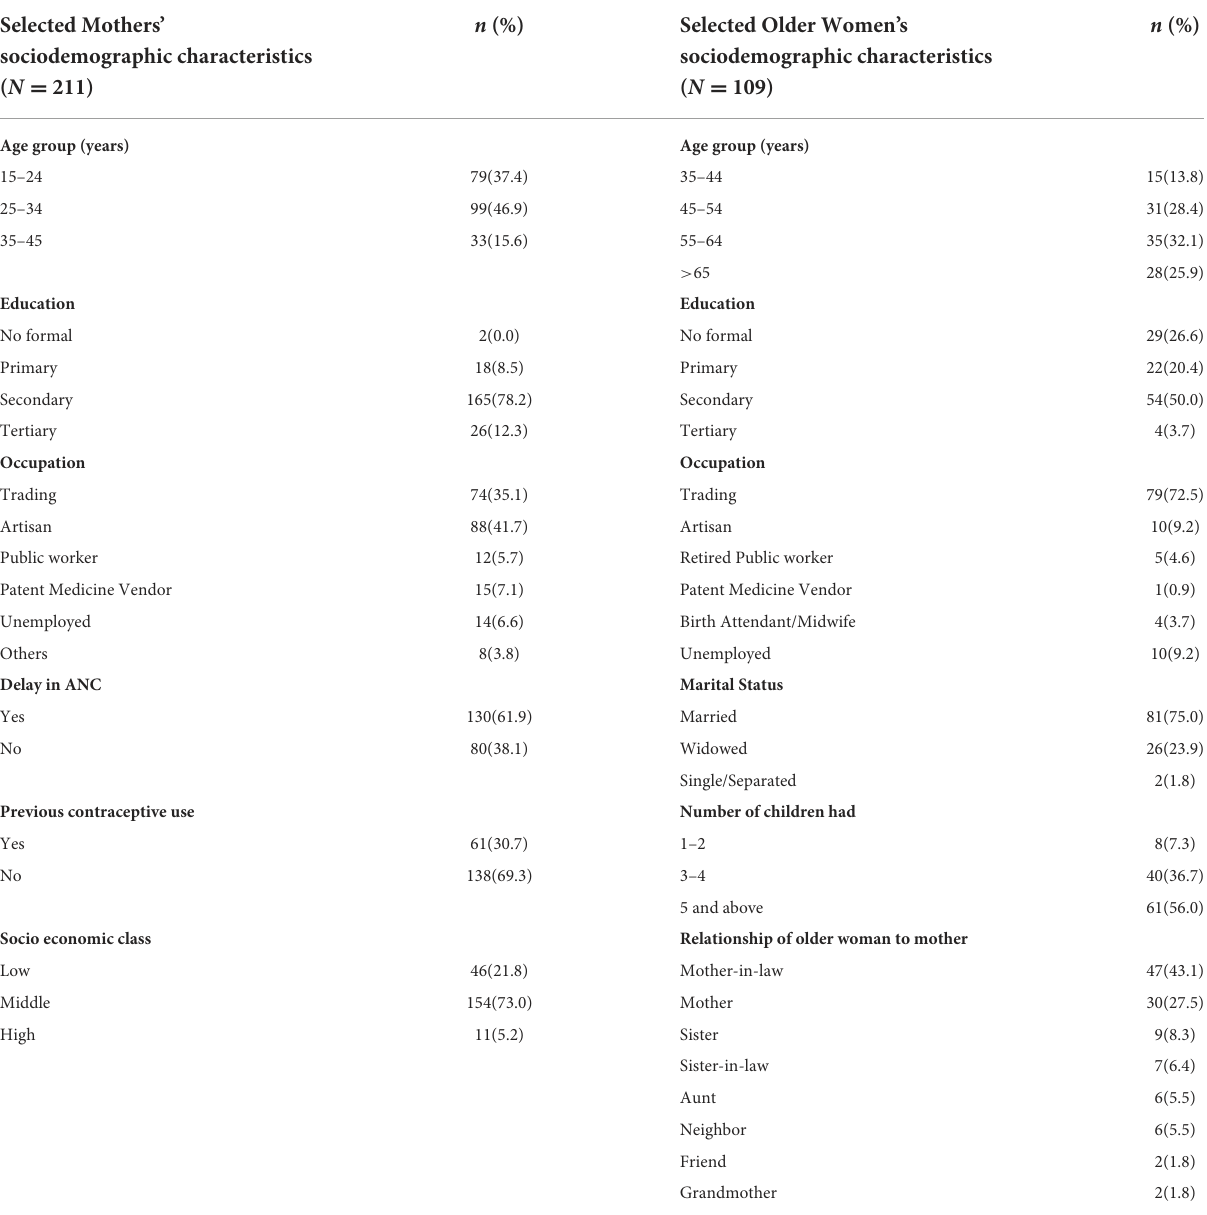
TABLE 1 Socio-demographic characteristics of Mothers of infants and older women caregivers from selected slum communities in Ibadan, Nigeria. Selected Mothers’